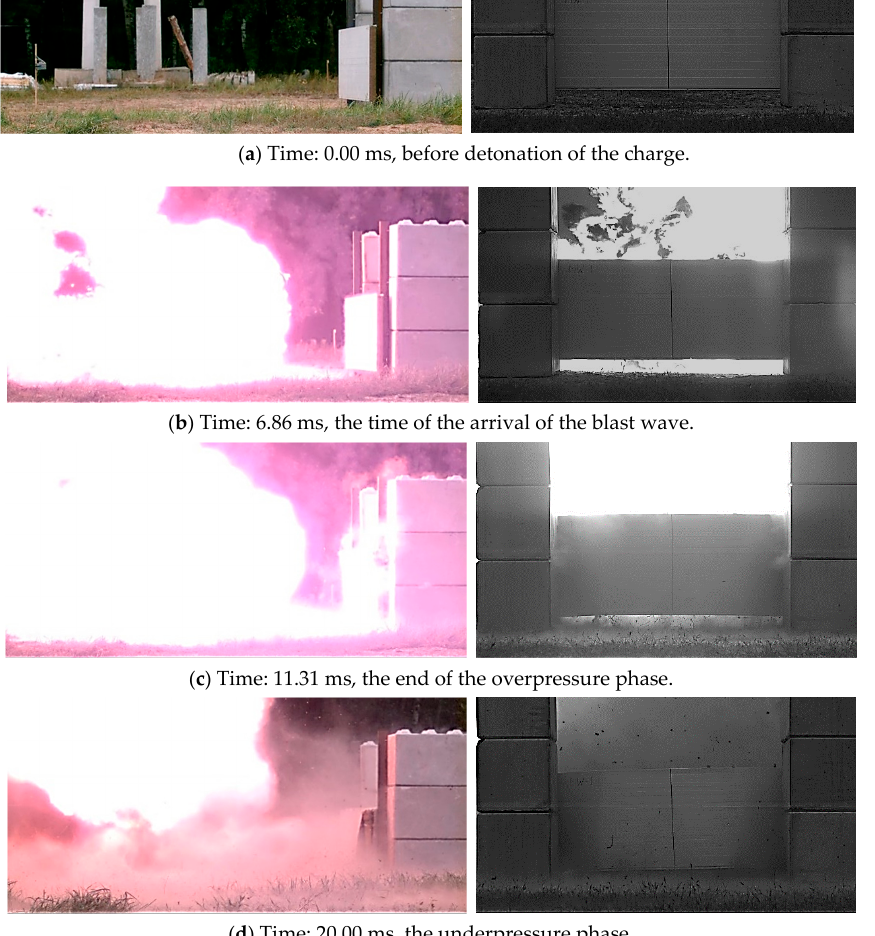
Figure 8. Selected frames recorded from Camera 1 (right side) and Camera (left side) for the following times: ( a ) 0.00 ms, before detonation of the charge; ( b ) 6.86 ms, the time of the arrival of the blast wave; ( c ) 11.31 ms, the end of the overpressure phase; and ( d ) 20.00 ms, the underpressure phase.